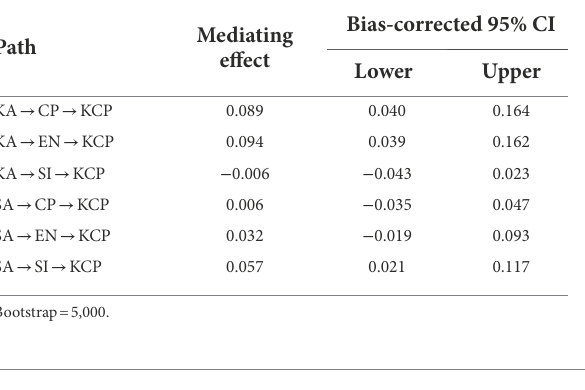
TABLE 12 Mediating effect analysis.